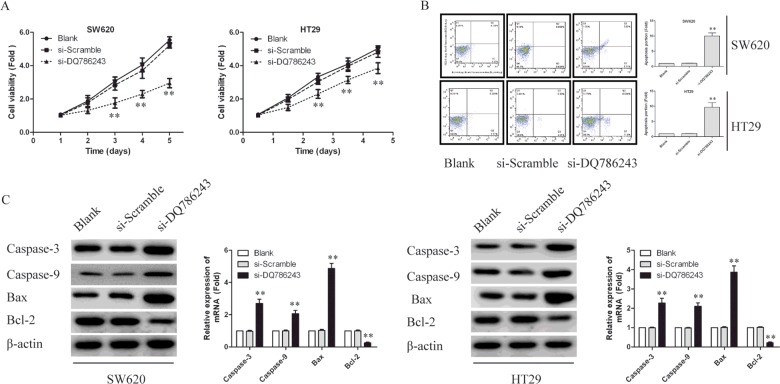
Knockdown LncRNA DQ786243 inhibited cell proliferation and promoted cell apoptosis in SW620 and HT29 cells(A) CCK-8 assays were performed. DQ786243 silencing notably inhibited the cell proliferation in both SW620 and HT29 cells. The data represent the means±S.D. from three independent experiments. The error bars denote the S.D., **P<0.01. (B) Apoptosis was assessed using FCM. Representative quadrant figures were presented. Knockdown of DQ786243 greatly increased the number of total apoptotic cells in both SW620 and HT29 cells. (C) Immunoblotting assays were performed to examine certain apoptosis-related proteins in SW620 and HT29 cells transfected with si-DQ786243 or si-Scramble. β-Actin was used as an internal control. All the results shown are representative of three independent experiments, **P<0.01.